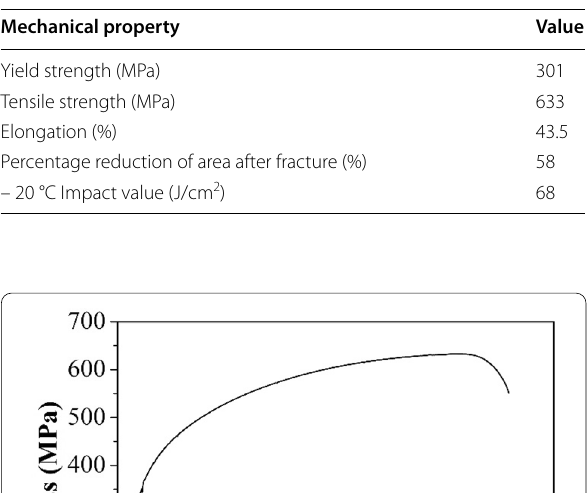
Al sample formed 13 7